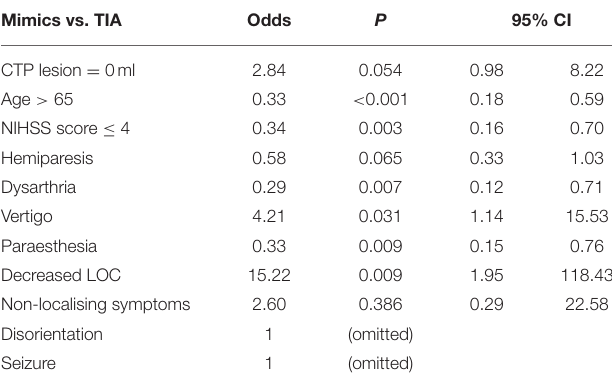
TABLE 4 | Multivariate regression model for predicting mimics vs. TIA. Mimics vs.